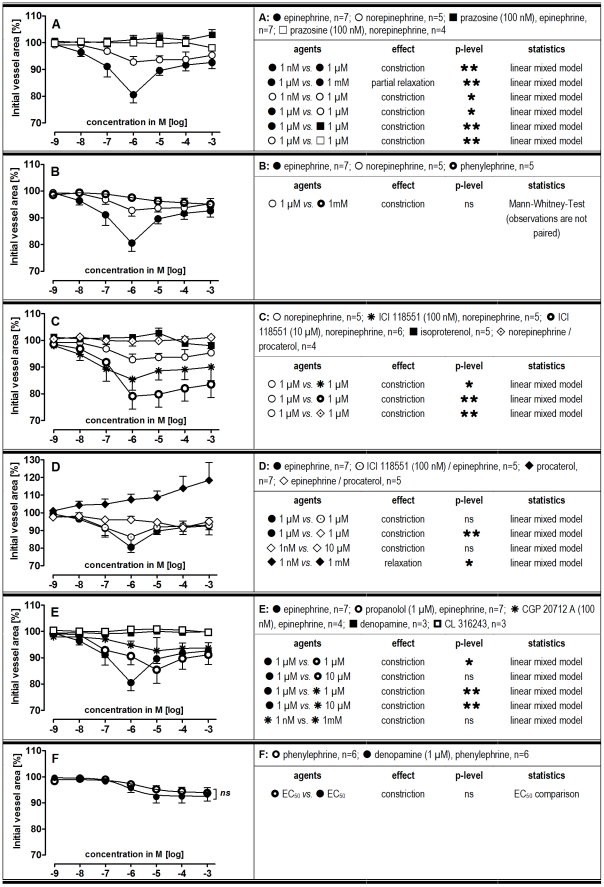
Responses of pulmonary arteries (PAs) to increasing dosages of adrenergic agents.
A-F) Pre-treatment concentrations were fixed. P<0.05 are considered as statistical significant and are indicated as followed  p<0.05,  p<0.01 and  p<0.001.